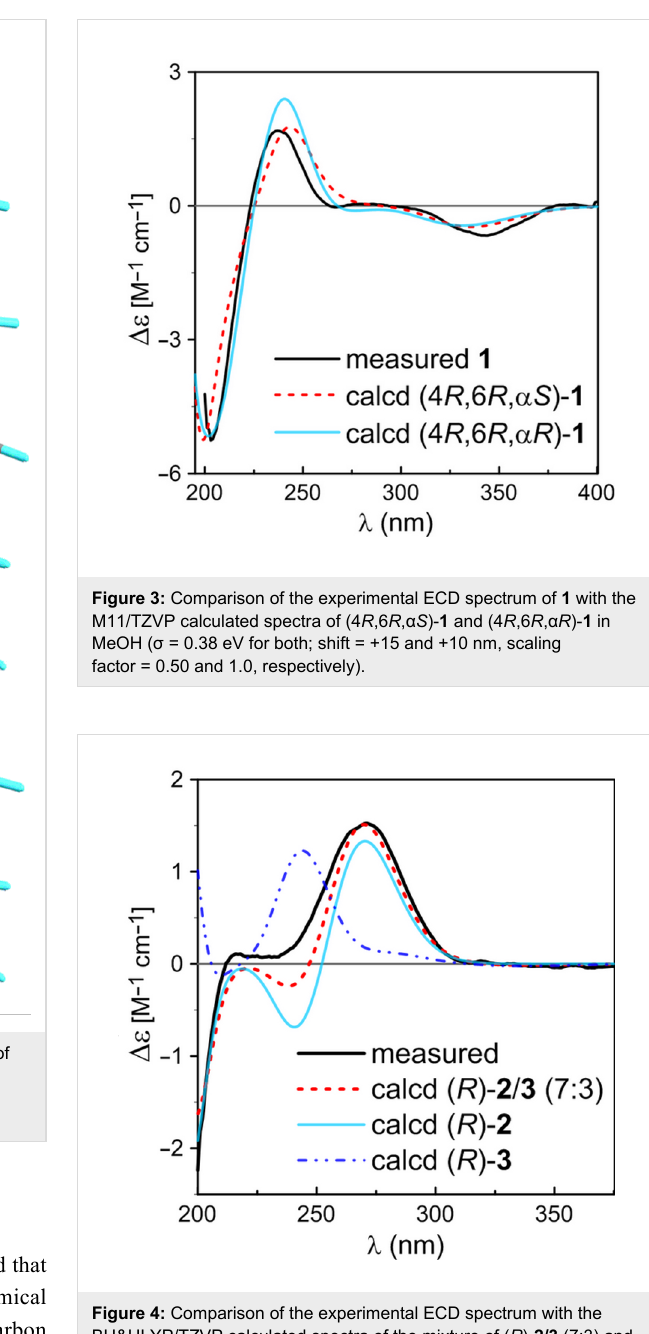
sis every 12 h. As a result, the interconversion between 2 and 3 was found to occur before 12 h and reach equilibrium (esti- mated ratios between 2 / 3 were 52:48 in 2 and 53:47 in 3 accord- ing to peak area intensities) at 36 h (Figure 5), whereas no changes were detected for the solutions kept in the dark (Figure 5), confirming the interconversion is a photoinduced geometrical